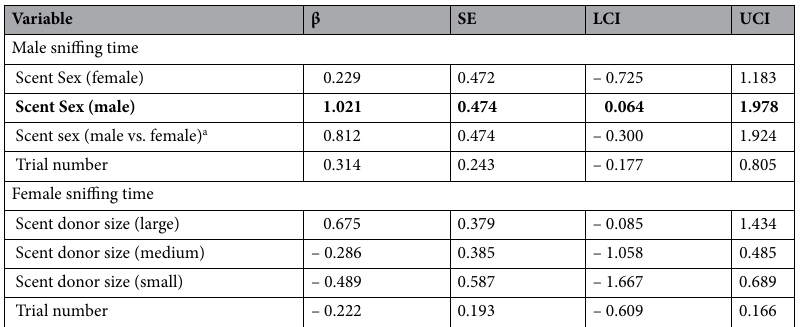
Table 1. Effect size (β), standard error (SE), lower (LCI) and upper (UCI) 95% confidence interval of explanatory variables for male and female domestic dog sniffing duration and nostril use when investigating conspecific pedal scent. A negative nostril indicates a right nostril bias associated with novel and/or arousal stimuli whereas a positive index indicates a left nostril bias associated with familiar neutral or pleasant odours. We performed model averaging of best models (ΔAICc < 2) to estimate the effect. Informative parameters are given in bold. a We used a Tukey’s contrast to compare the sniffing duration for male and female